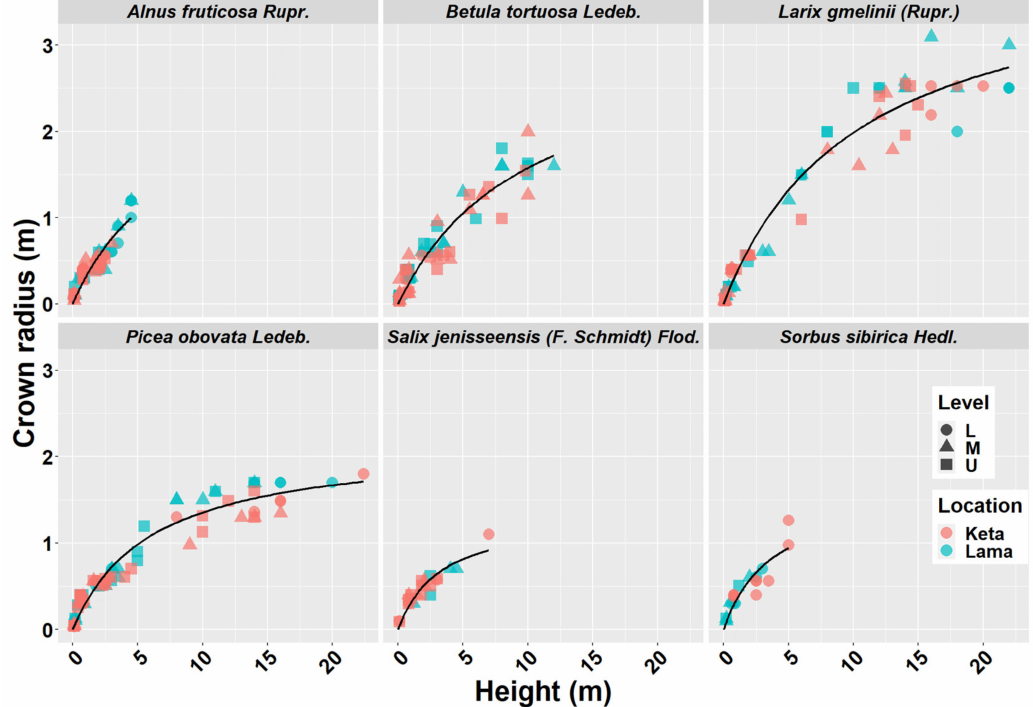
Figure A3. General crown radius, height models for six tree species at two locations of Keta and Lama. Statistical parameters of models are presented in Table 2. Level: L—lower elevational zone, M—middle elevational zone, U—upper elevational